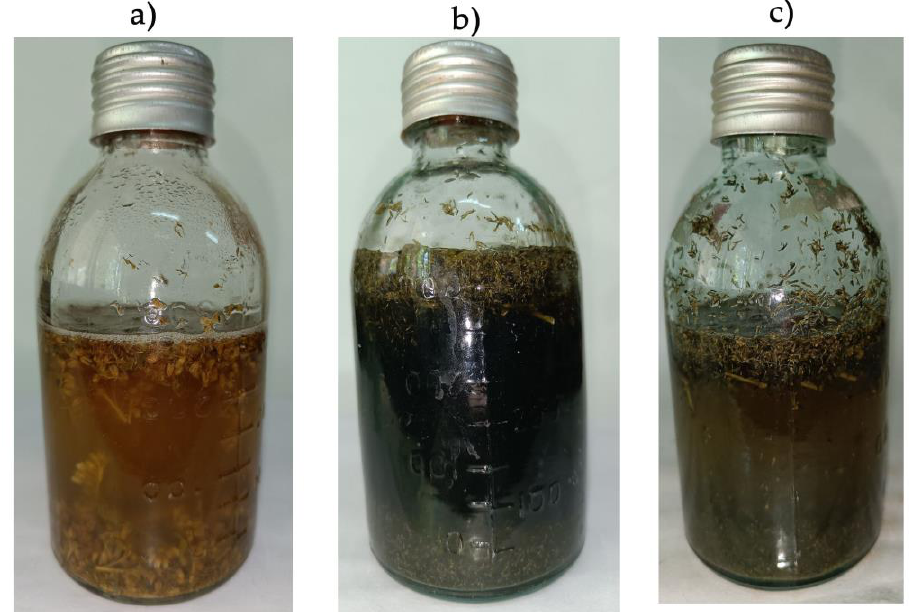
Figure 5. The process of Solidago canadensis invasive weed degradation (34 days) using different experimental treatments: control degradation by native Solidago microbiome ( a ); experimental degradation by inoculum of methane-producing and sulfate-reducing bacteria ( b ); degradation under the influence of 500 mg L − 1 Cu(II) ( c ).